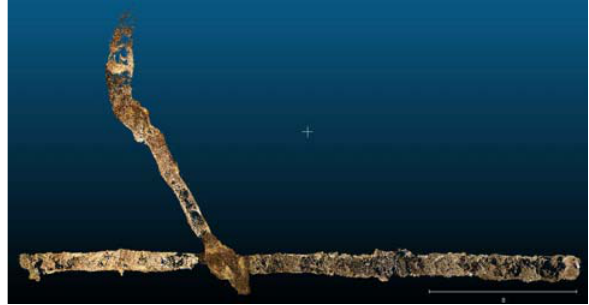
Figure 5. Point cloud generated out of 892 images to reconstruct galleries of about 40 m length.